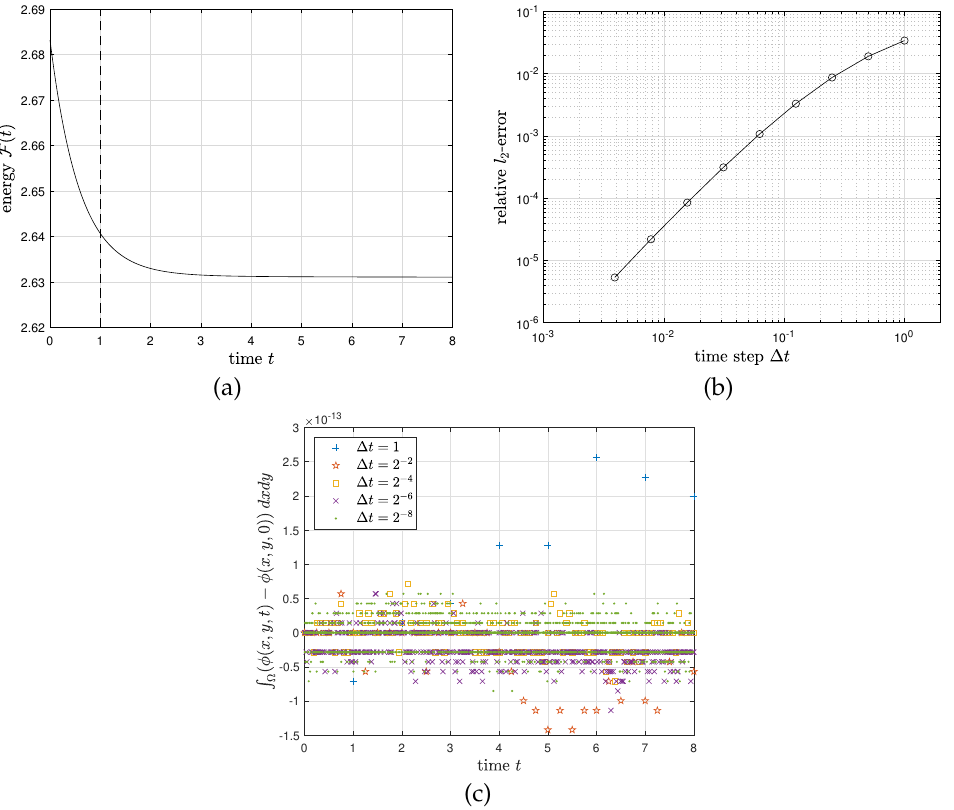
Figure 1. ( a ) Evolution of F ( t ) for the reference solution with (cid:101) = 0.025, ∆ x = ∆ y = 1 ∆ t = 2 − 10 . ( b ) Relative l ( x , y ,1 ) for ∆ t = 2 − 8 ,2 − 7 , . . . ,1. ( c ) Evolution of (cid:82) Ω ( φ ( x , y , t ) − 2 -errors of φ φ ( x , y ,0 )) dxdy for various time